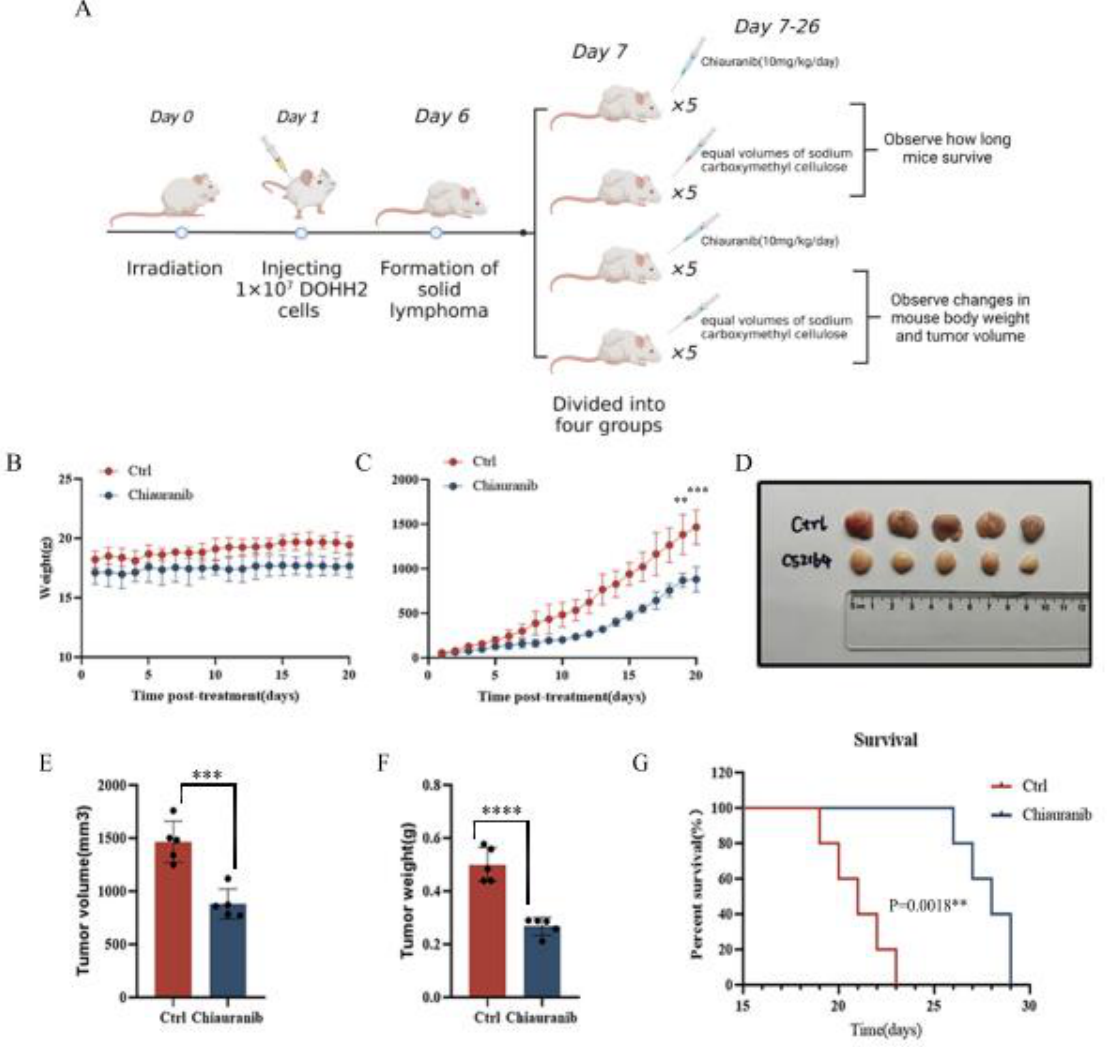
Figure 6. Chiauranib inhibits t-FL progression in xenograft models. ( A ) Schematic outline of the xenograft models. ( B ) Changes in body weight in mice. ( C ) The chiauranib-treated mice had lower tumor volumes than the control mice. ( D ) Images of tumors from xenograft models (n = 5). The chiauranib-treated mice also had lower ( E ) tumor volumes, ( F ) weights, and ( G ) improved survival curves. A total of 10 mice (5 control, 5 chiauranib) were monitored for survival for an additional ten days. (** p < 0.01, *** p < 0.001, **** p < 0.0001).